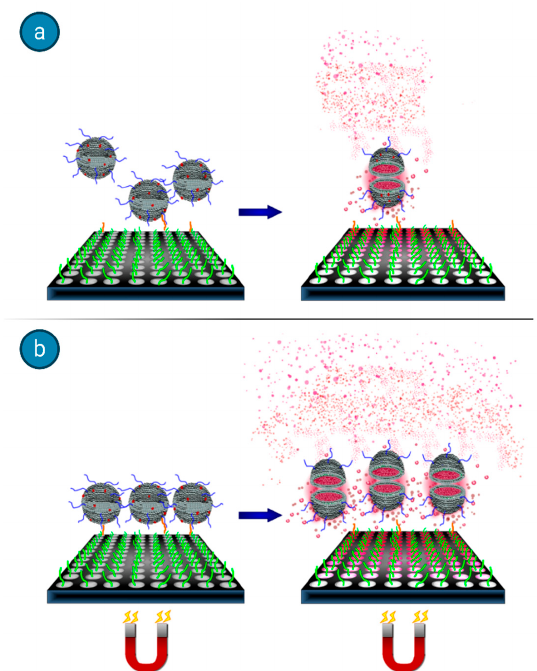
Figure 11. Sandwich hybridization assay with DNA reporter probe-labeled fluorescent dye-encapsulating magnetoliposomes for the quantification of target nucleic acids. ( a ) The analyte is captured on the surface, but the interactions are subject to mass transfer limitations. ( b ) When an underlying magnetic field is applied, additional binding interactions with the immobilized target are promoted, leading to increased assay sensitivity and reduced assay times and reagent concentrations. Figure adapted with permission from [65]. Copyright 2014 American Chemical Society. Biology 2020 , 9 , x